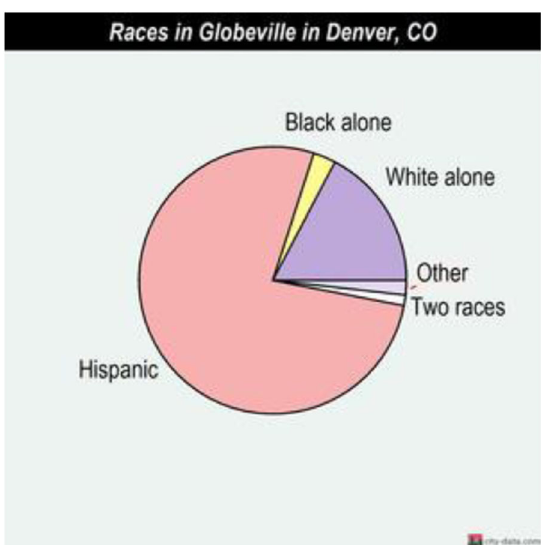
Fig. 5 Races in Globeville, Source: